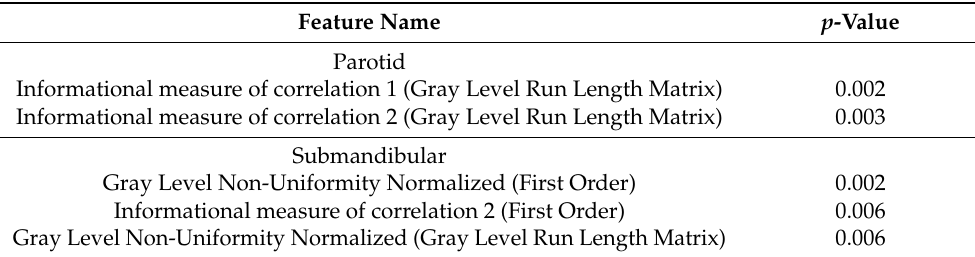
Table 4. p -values for statistically significant texture features. See Table A1 (Appendix A) for the definition of First Order and Gray Level Run Length